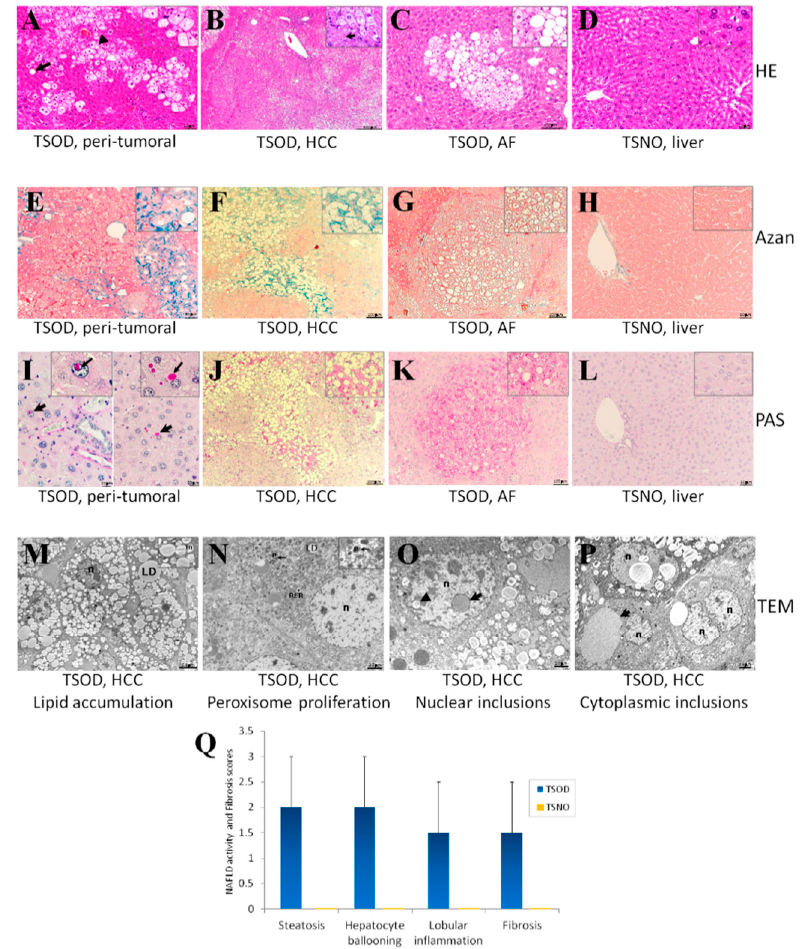
Figure 1. Representative histopathological (H&E) ( A) –( D ), Azan ( E ) – ( H ), Periodic acid-Schiff (PAS) ( I )–( L ) staining, TEM ( M ) – ( P ) features, and NAFLD activity (NAS) and fibrosis scores ( Q ) in 60-week-old Tsumura, Suzuki, Obese Diabetic (TSOD) mice livers ( A , C , E , G , I , K ) and hepatocellular carcinomas (HCCs) ( B , F , J , M – P ), and control Tsumura, Suzuki, Non-Obese (TSNO_ mouse liver ( D , H , L ). Lipid degeneration, fatty change (arrows), mild inflammation ( A ), vacuolated (lipids-accumulated) HCCs with eosinophilic droplets (arrow) ( B ) and altered foci (AF) ( C ) in TSOD mouse livers. Azan-positive regions (fibrosis) TSOD liver ( E ), HCC, AF and PAS-positive nuclear and cytoplasmic inclusions (arrows) ( I ), HCC ( J ), and AF ( K ) were observed in TSOD mice livers. TEM analysis ( M) –( P ) demonstrated strongly increased number of lipid droplets (LD), peroxisomes (p), numerous nuclear (n), cytoplasmic inclusions with grey homogenous material (arrows) and lipids (triangle arrows), and mitochondria (m) in HCCs of TSOD mice. Bars: 200 µ m ( B ); 100 µ m ( C , F , G , J , K ); 50 µ m ( A , D , E , H , L ); 20 µ m ( I ); 5.6 µ m ( M ); 2.5 µ m ( N , P ); 2.0 µ m ( O